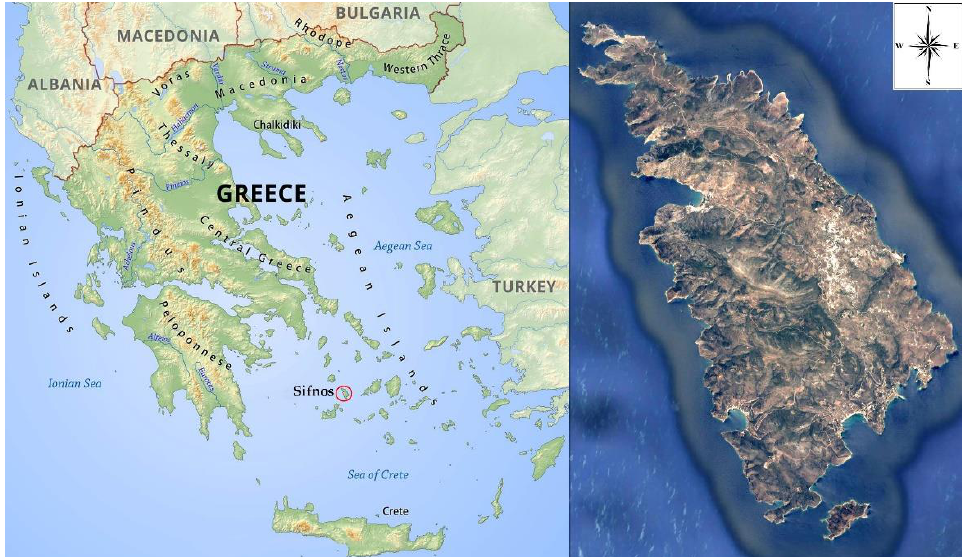
Figure 1. The map of Sifnos and its geographical location in Greece.